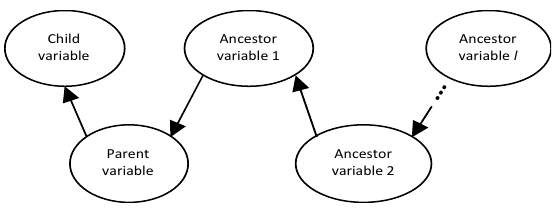
Figure 4. Generic BN structure for the tagging output. Table 3. Example of the raw data, classified tags and BN mapping for one row of data. Raw Data